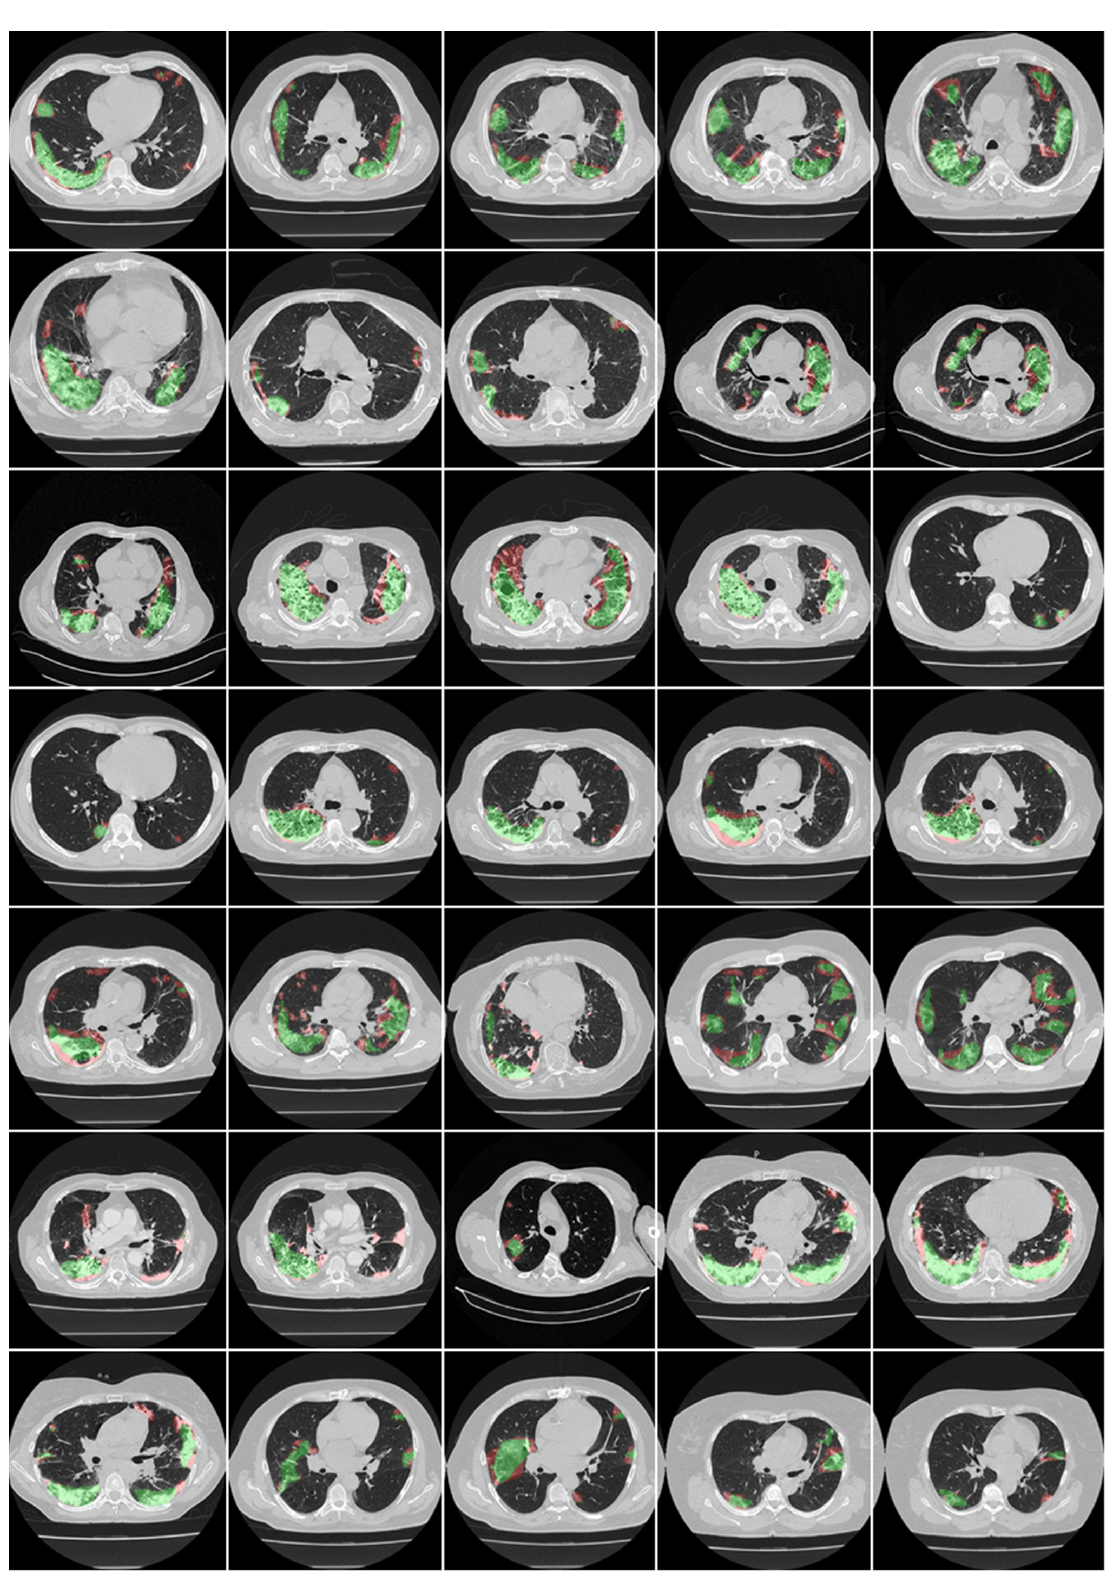
Figure A1. Results of visual lesion overlays showing PSPNet (green) vs. MD 1 (red).